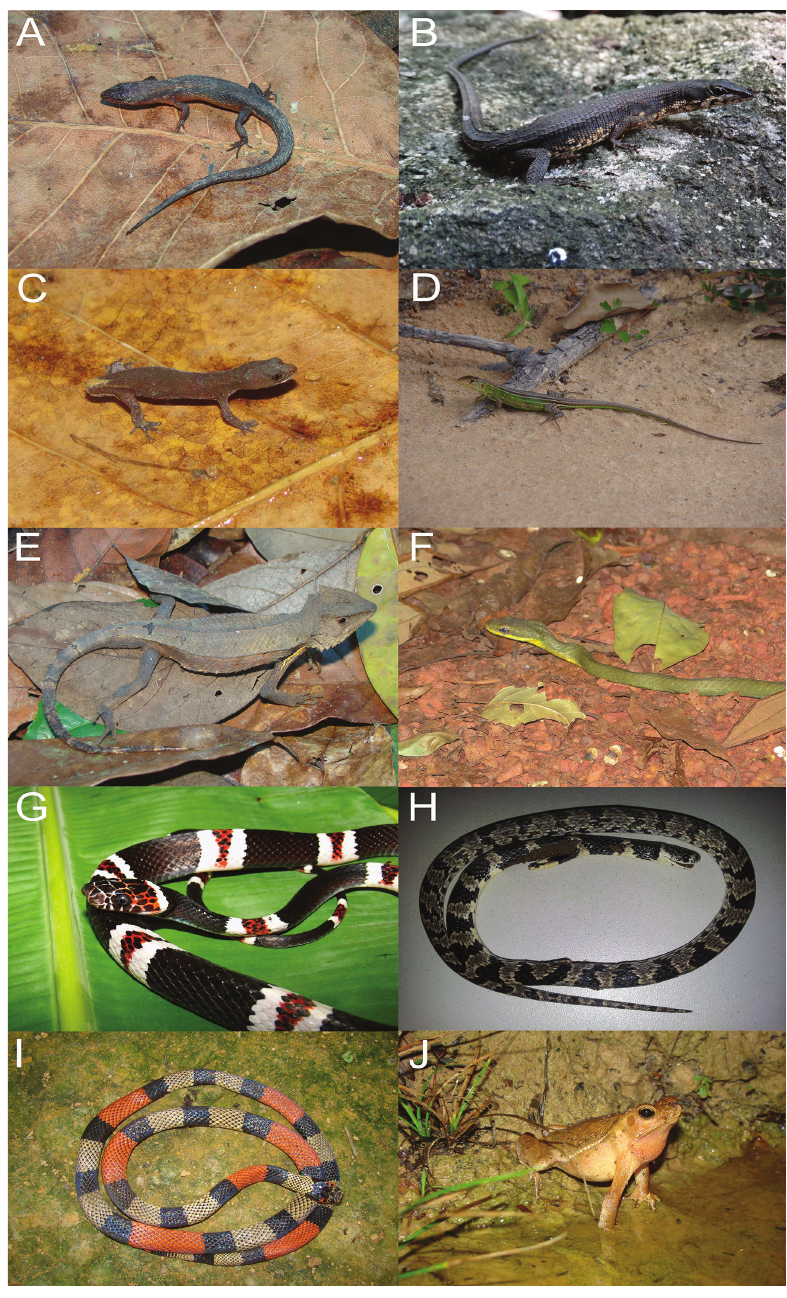
Figure 4. Some amphibians and reptiles recorded in the Gurupi Biological Reserve, Maranhão, Brazil. A Leposoma percarinatum B Neusticurus bicarinatus C Coleodactylus septentrionalis D Cnemidophorus cryptus E Stenocercus dumerilii F Phrynonax poecilonotus G Rhinobothryum lentiginosum H Sibynomorphus mikanii septentrionalis I Micrurus spixii martiusi J Rhinella gildae . Photo credits of P. poecilonotus ( F ) belong to Eloisa Mendonça, R. lentiginosum ( G ) to Saymon Albuquerque and M. A. de Freitas for